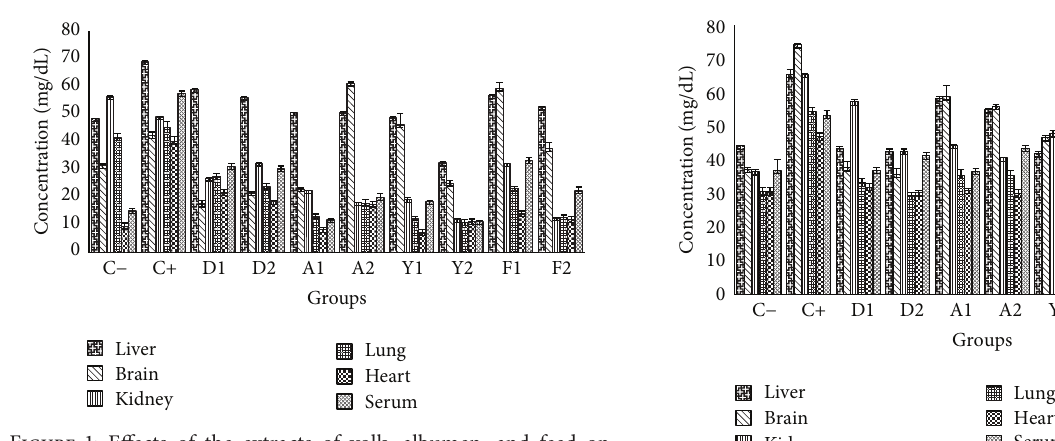
Figure 1: Effects of the extracts of yolk, albumen, and feed on triglyceride profiles in liver, brain, kidney, lung, heart, and serum (mg/dL). Each value represents mean ( 𝑛 = 5 ).